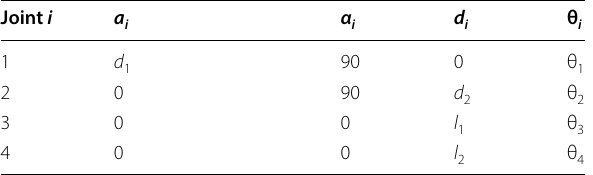
Table 2 D-H parameters